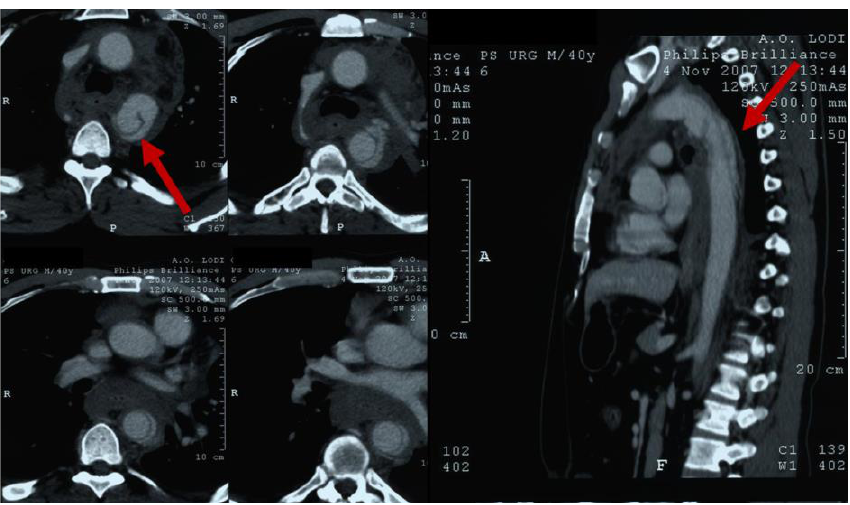
Figure 1. Angio-Computed Tomography chest scan of a patient with BTAI at isthmus, causing intimal tear (red arrow) in axial (on the left) and sagittal (on the right) views.